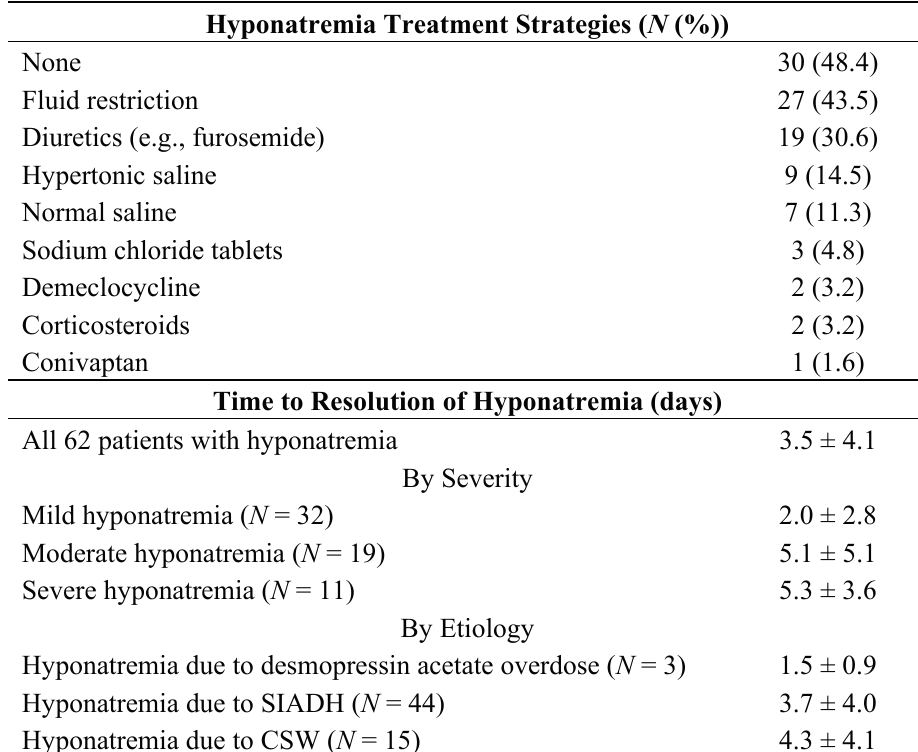
Table 4. Treatment strategies, treatment efficacy and clinical outcomes of postoperative hyponatremia seen in 62 patients after undergoing transsphenoidal resection of a pituitary mass at the authors’ institution between January, 2006, and December,